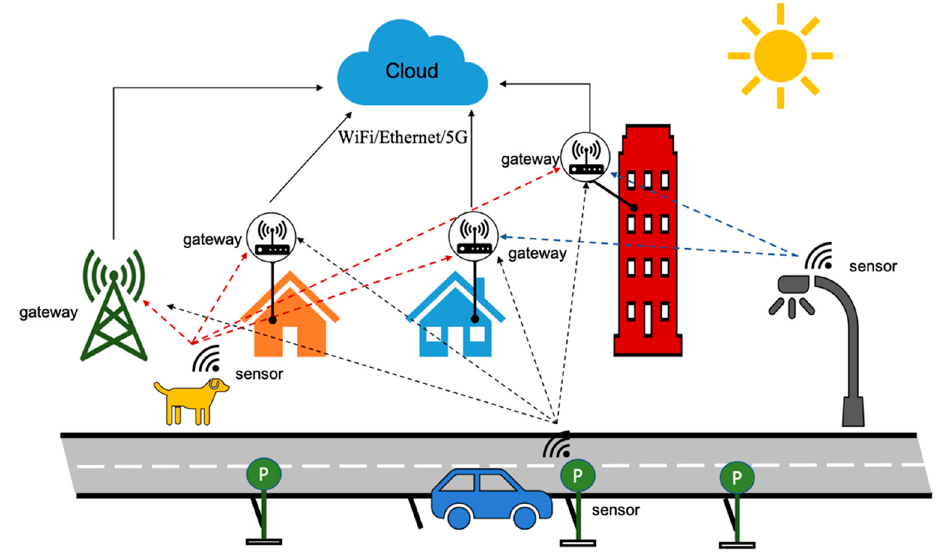
Figure 1. LPWAN with GW diversity